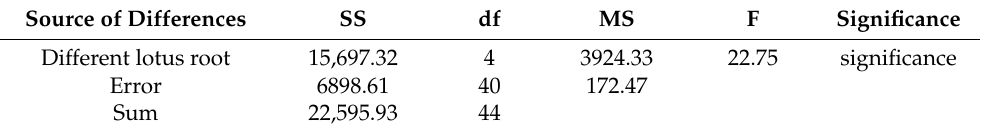
Table 9. AVOVA of the maximum pull-out force of different lotus roots at the burial depth of 15 cm.